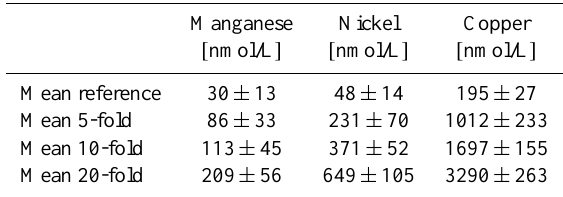
Table 1. Mean concentrations of Mn, Ni, and Cu in the culture so- lutions. Reference = North Sea water without added trace elements, 5-, 10- and 20-fold indicate 5-, 10-, and 20-fold concentrations of natural North Sea